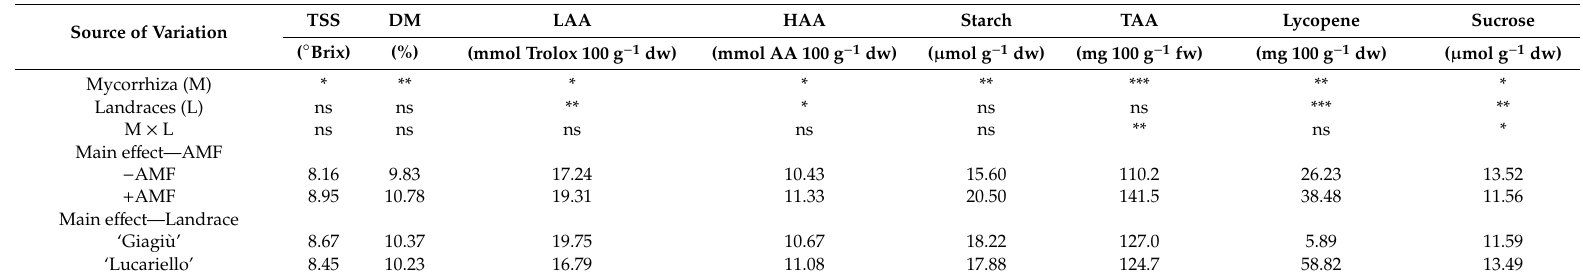
Table 3. Significance of the main e ff ects and the interactions on total soluble solids (TSS) content, dry matter, lipophilic and hydrophilic (LAA and HAA), starch, lycopene and sucrose. Values represent means of three